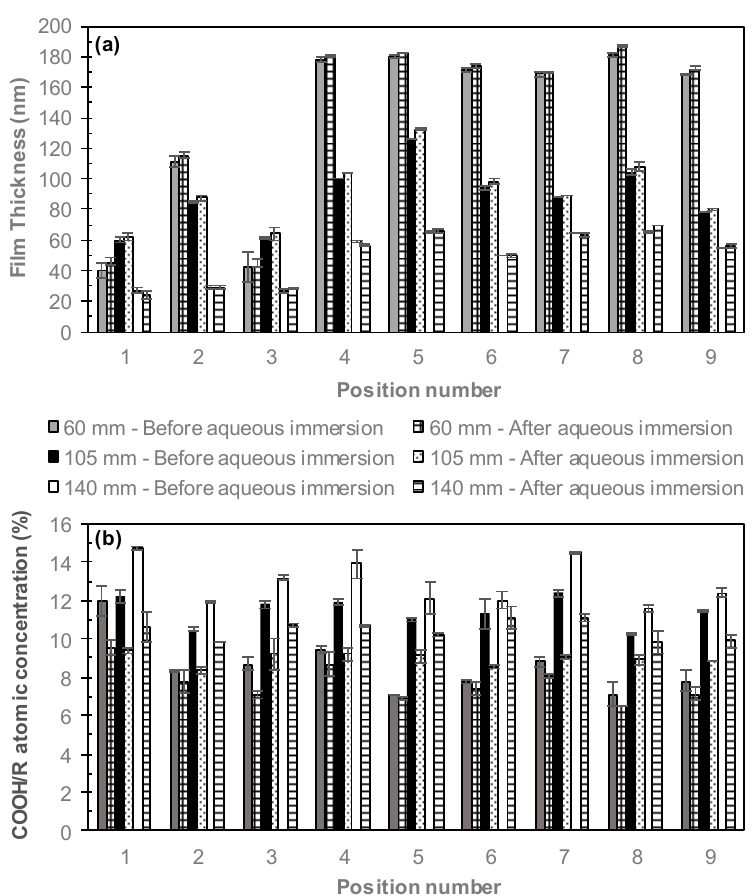
Figure 6. ( a ) Film thickness and ( b ) COOH / R concentrations of ppAAc films deposited 60, 105 and 140 mm from the electrode, before and after aqueous immersion (error bars ± standard deviation).